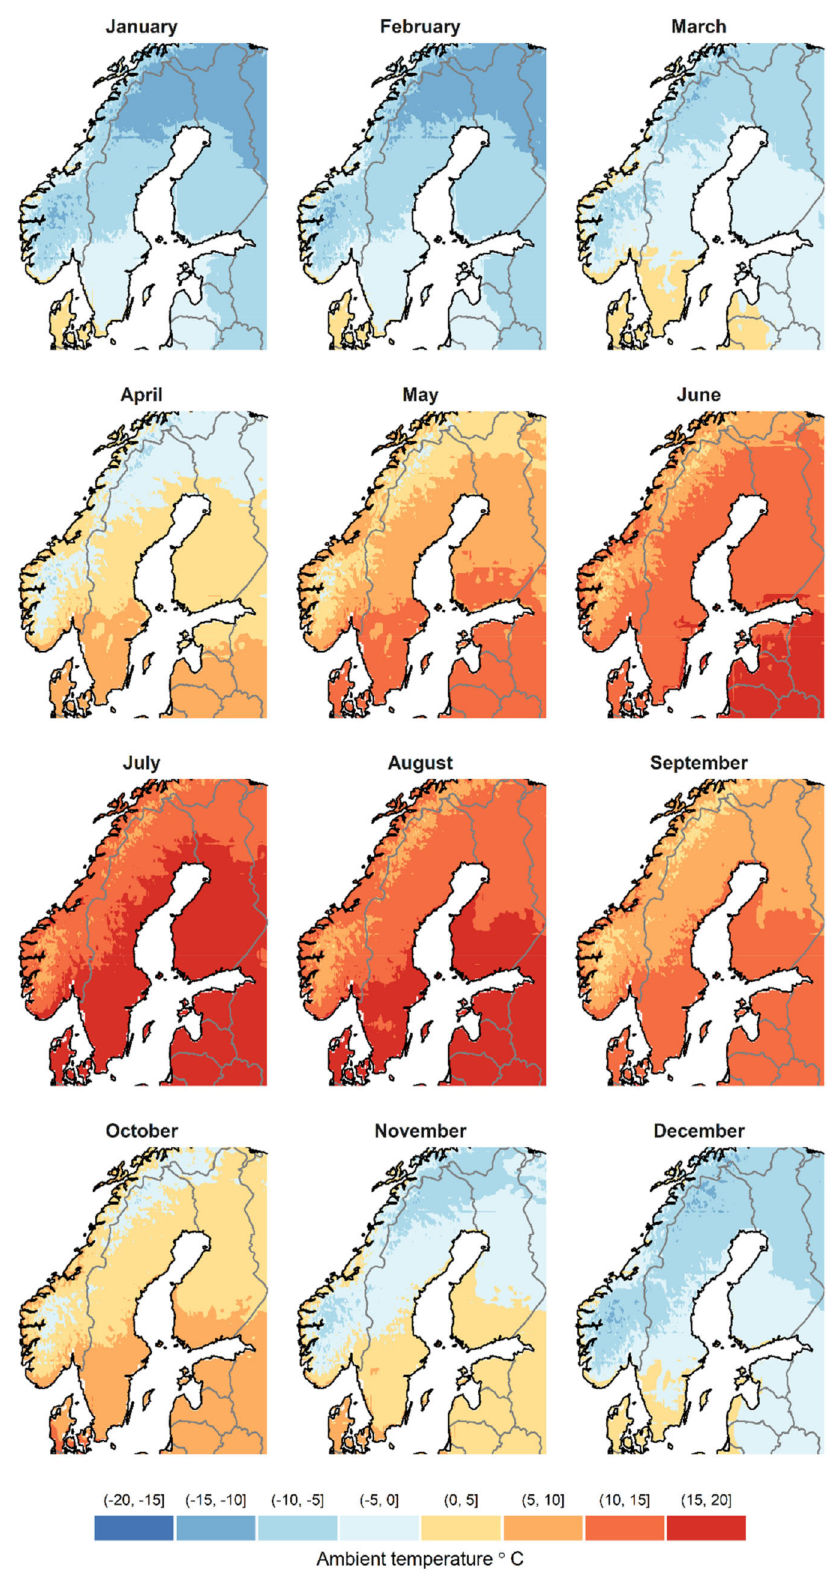
Figure 1. Monthly average daily ambient temperature (T a , ◦ C) maps for the Nordic and Baltic countries. Values from the ECMWF-ERA-5 dataset with a coverage period of 2005–2016 retrieved from PVGIS as a 0.1 ◦ × 0.1 ◦ grid both in latitude and longitude, extending from 54.5 ◦ N to 70 ◦ N in latitude and 4.5 ◦ E to 31.5 ◦ E in